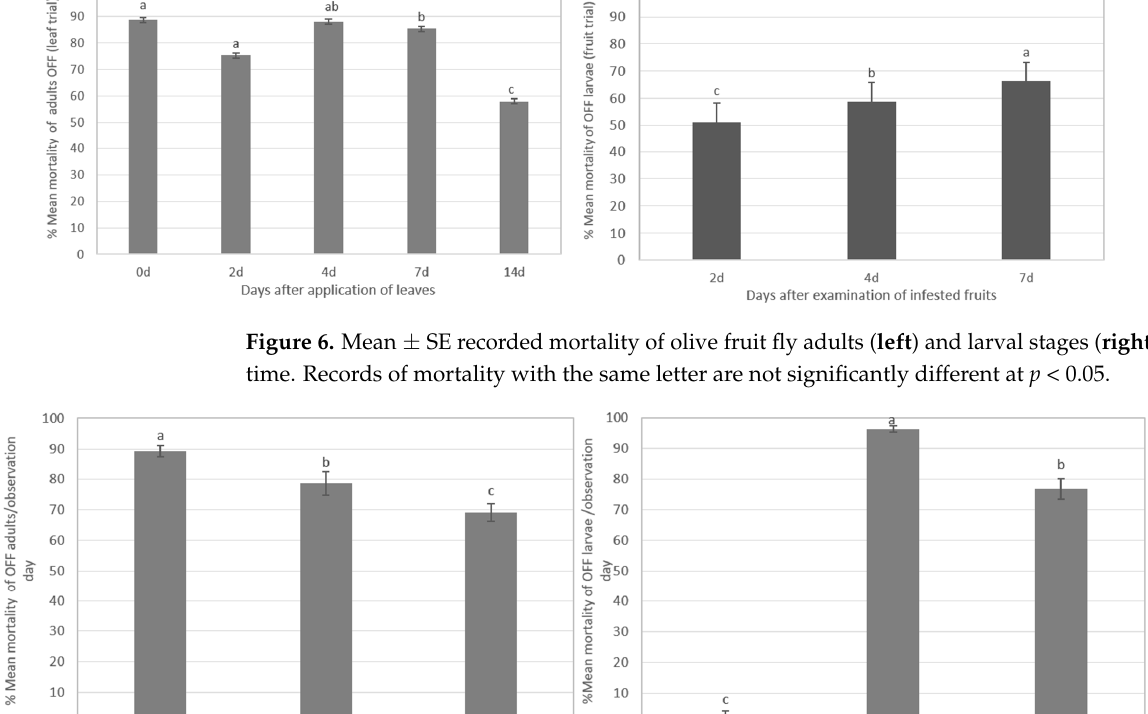
Figure 7. Mean ± SE recorded mortality of olive fruit fly adults ( left ) and larval stages ( right ) for each tested insecticide. Records of mortality with the same letter are not significantly different at p < < 0.05.